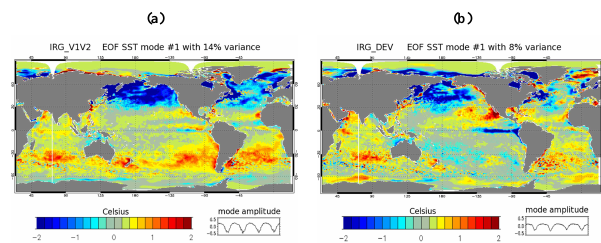
Fig. 25. Cumulative temperature trend (°C) over the 2007-2011 period near 300 m for IRG_V1V2 (a) and IRG_DEV (b) systems.